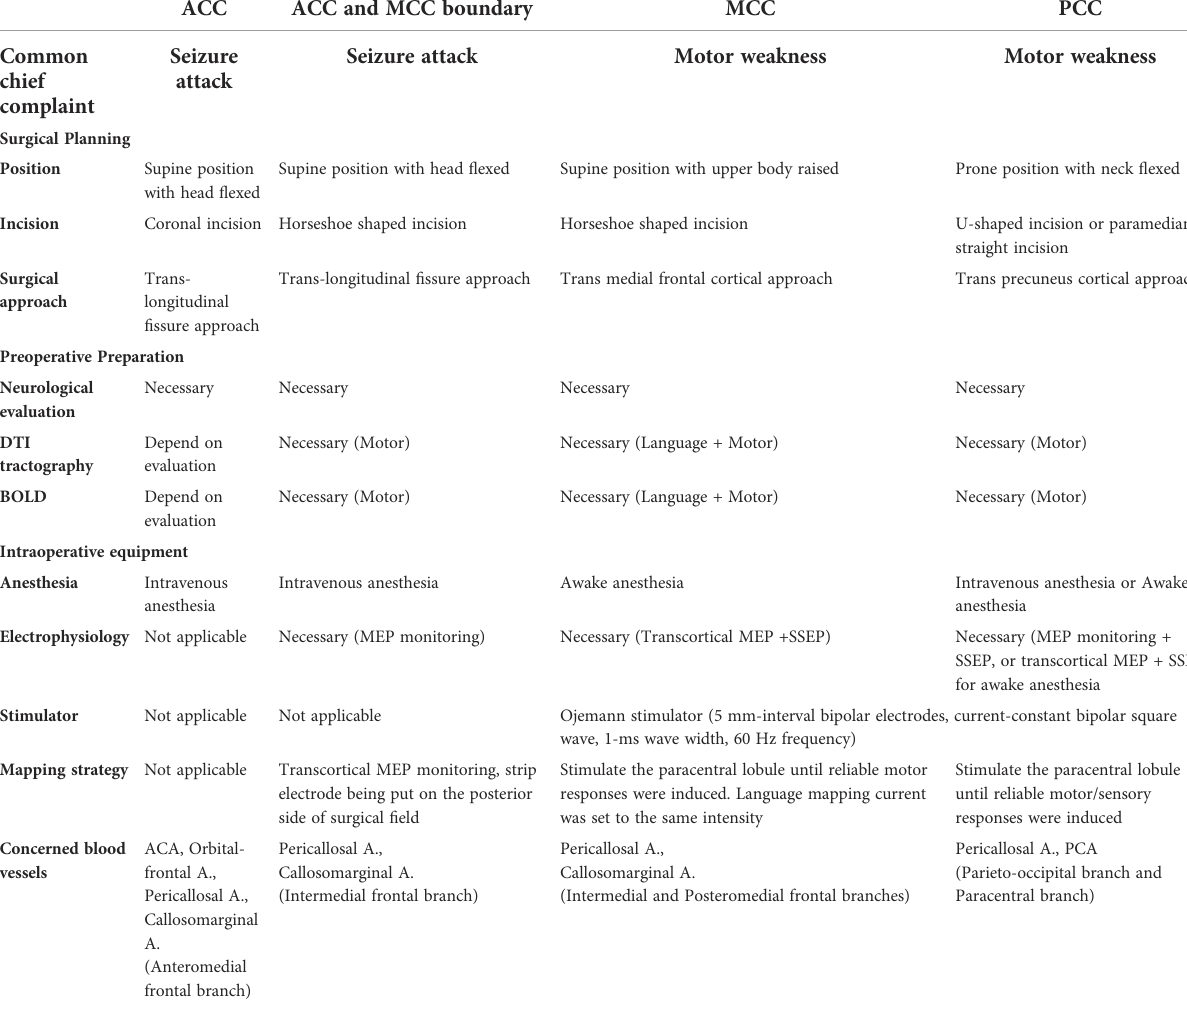
TABLE 8 Recommendable regimen of surgical approach and techniques for pure CG glioma in different